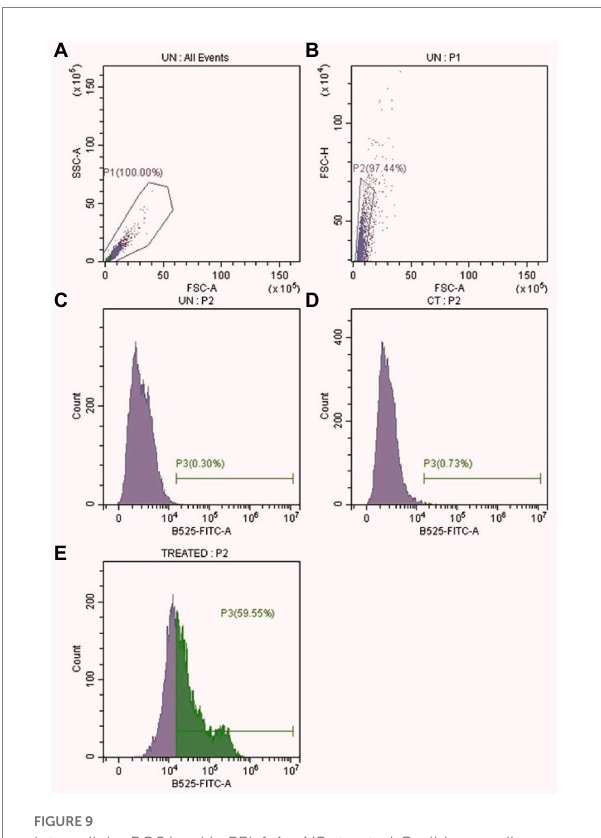
FIGURE 9 Intracellular ROS level in PEI-f-Ag-NPs treated C. albicans cells. (A) All events (B) Selected events (10000) (C) Unstained Control (D) Stained Control (E) PEI-f-Ag-NPs